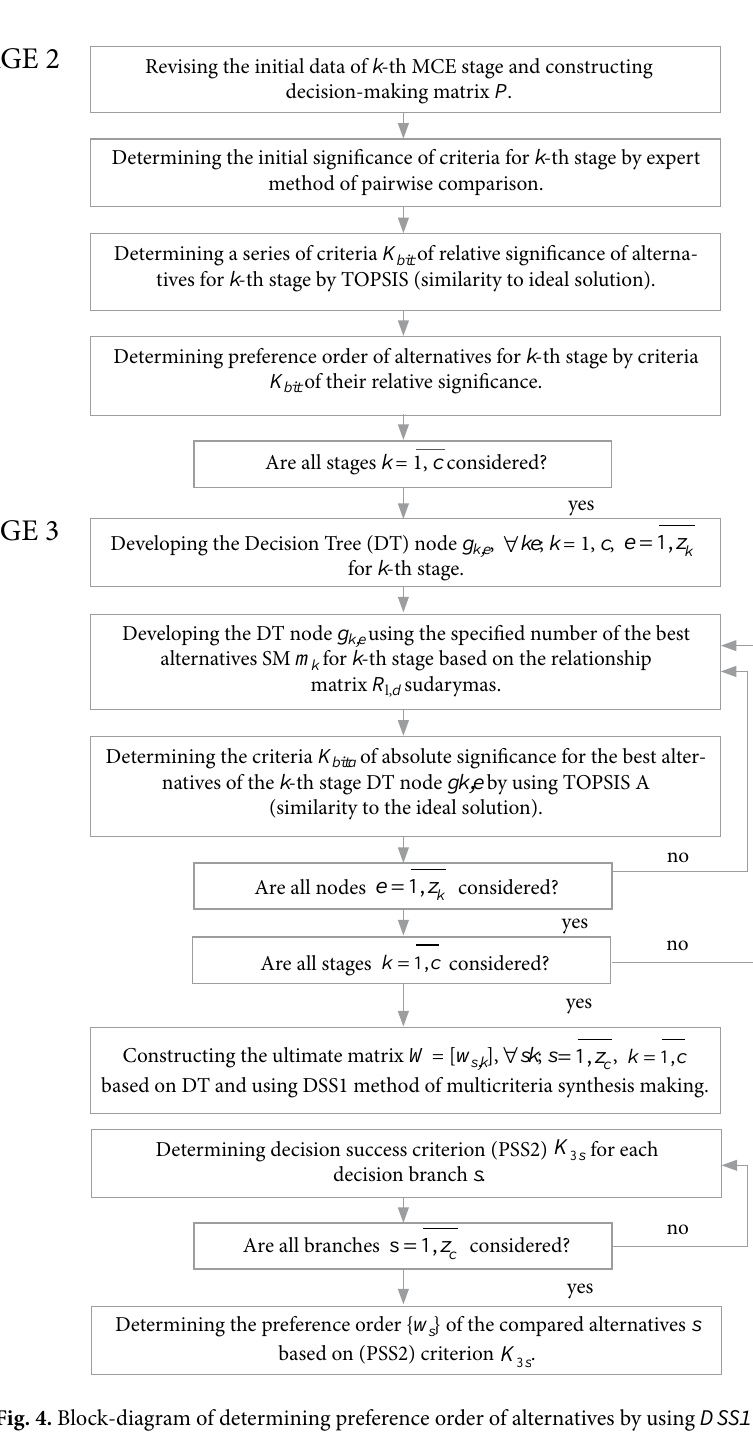
Fig. 4. Block-diagram of determining preference order of alternatives by using DSS1